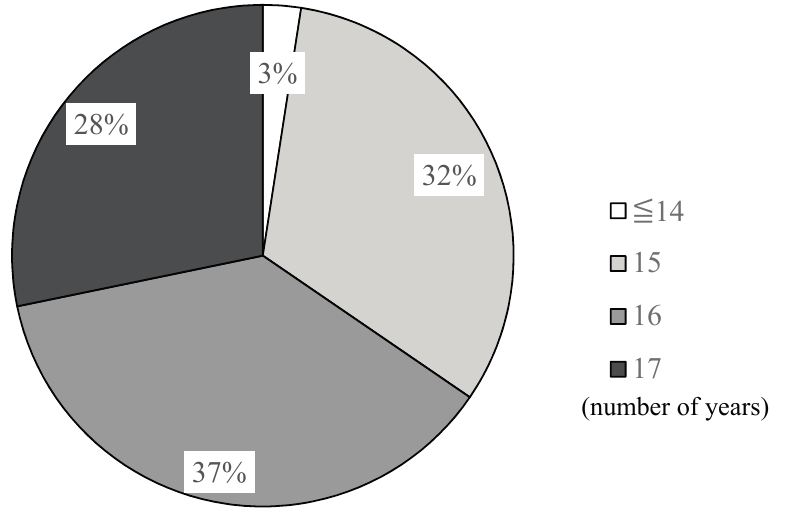
Figure 3. The proportion of time series data length (in years) for